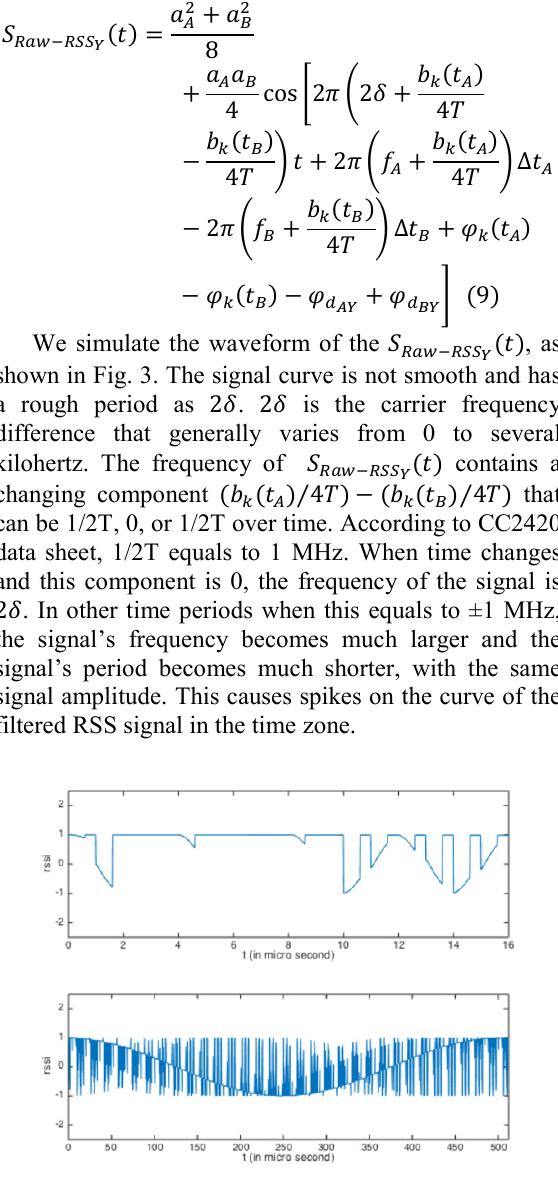
Fig. 3. Filtered RSS Signal in 1 Symbol Period and 32 Symbol